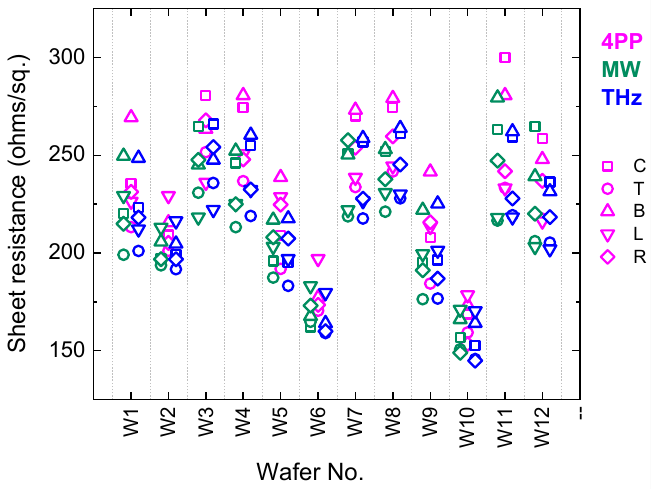
Figure 11. Sheet resistance of 12 wafers diced into 2 × 2 cm sections, measured using the four-point probe, microwave resonator and THz time-domain spectroscopy. Five sections from different locations were chosen and measured in each wafer, designated C (centre), T (top), B (bottom) L (left), R (right). The measured data points are shown in red for 4PP, green for MW and blue for THz; and different locations (C, T, B, L, R) are represented by different symbols. The uncertainties are smaller than the size of the data symbols.